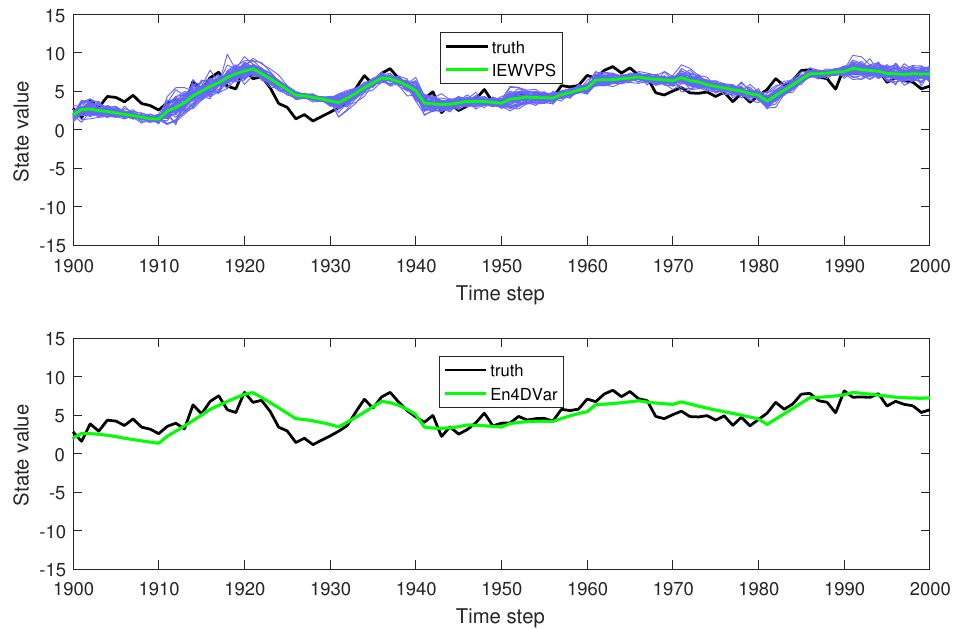
Figure 9. Trajectories of the No. 50 variable during the last 100 model steps . The black line represents truth, blue lines represent the evolution of each particle, and the green line represents the ensemble mean. Experiments are implemented with N x = 100 and N e =